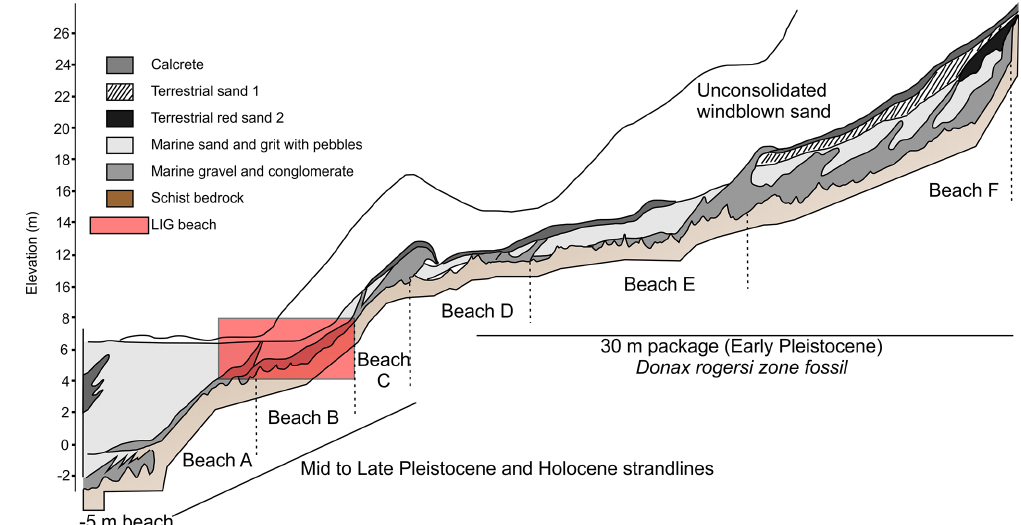
Figure 2. Schematic east–west cross section through the raised beach deposits of southern Namibia (modified from Runds, 2017). Subtidal to + 10m elevations represent the A, B and C beaches, and the + 30m package represents the D, E and F beaches). Data were compiled originally from Hallam (1964) and Jacob (2001). Beach “B” is commonly ascribed to MIS 5e but has not been dated